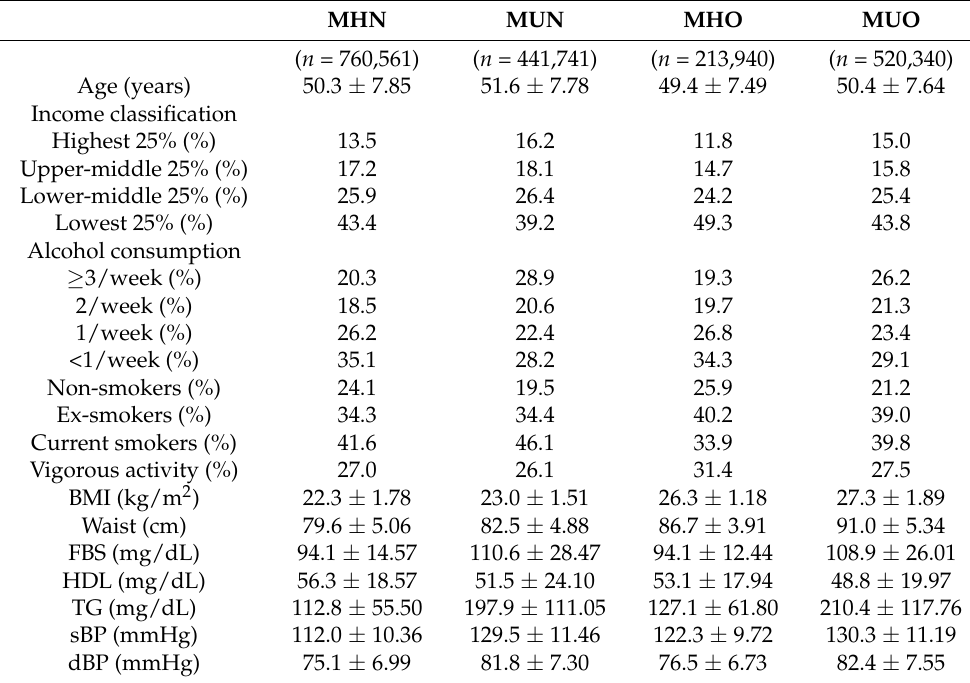
Table 1. Characteristics of the study population at the baseline (men).